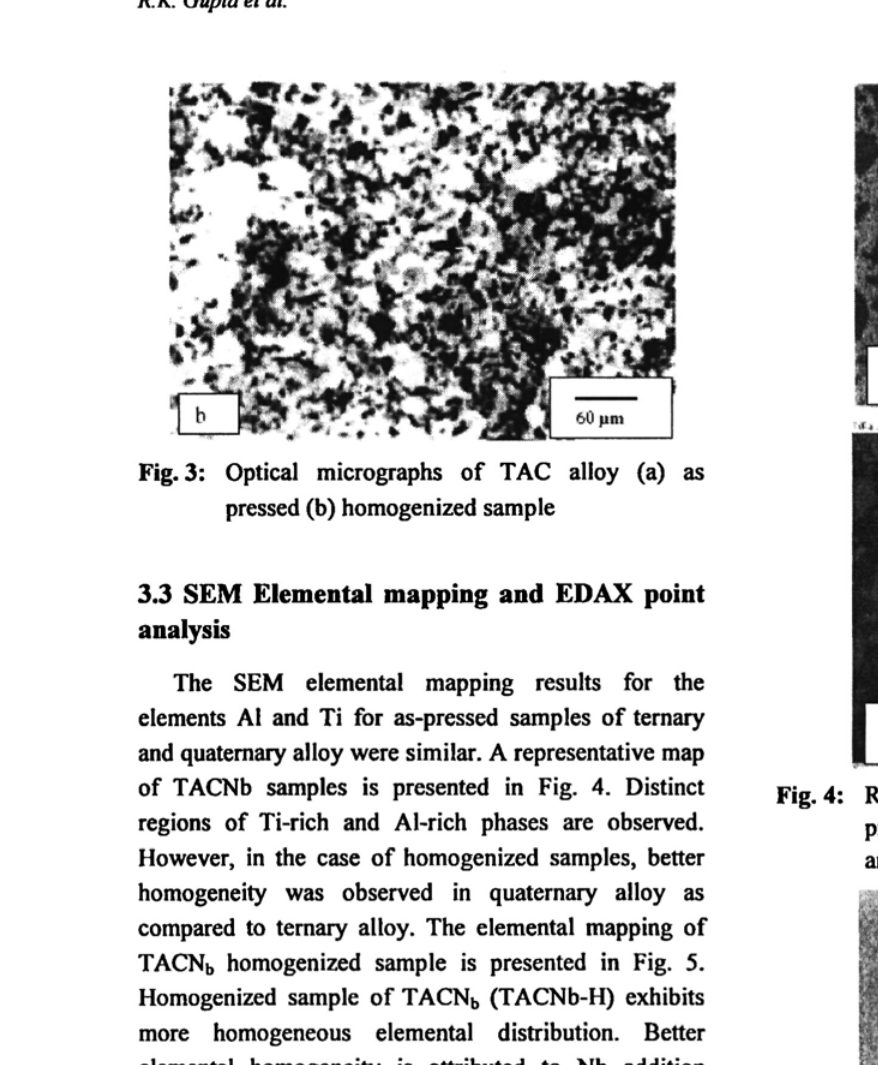
Fig. 4: Representative SEM elemental mapping of as- pressed sample showing distribution of: (a) Ti and (b) AI in TACN